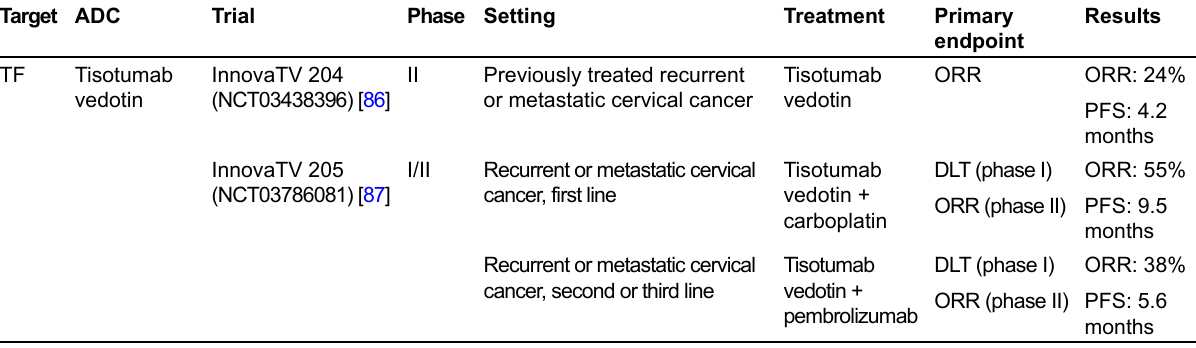
Table 3. Main clinical trials of ADCs in endometrial and cervical cancer ( continued )